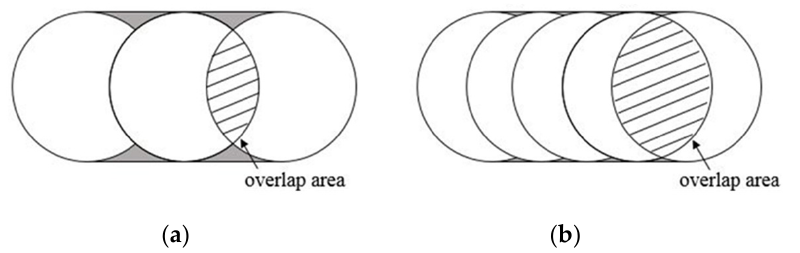
Figure 1. Schematic of pulse overlap at different laser scan rates and pulse repetition rates: ( a ) at a high scan rate or low pulse repetition rate, the pulse overlap area is small; ( b ) at a low scan rate or high pulse repetition rate, the pulse overlap area is significant.